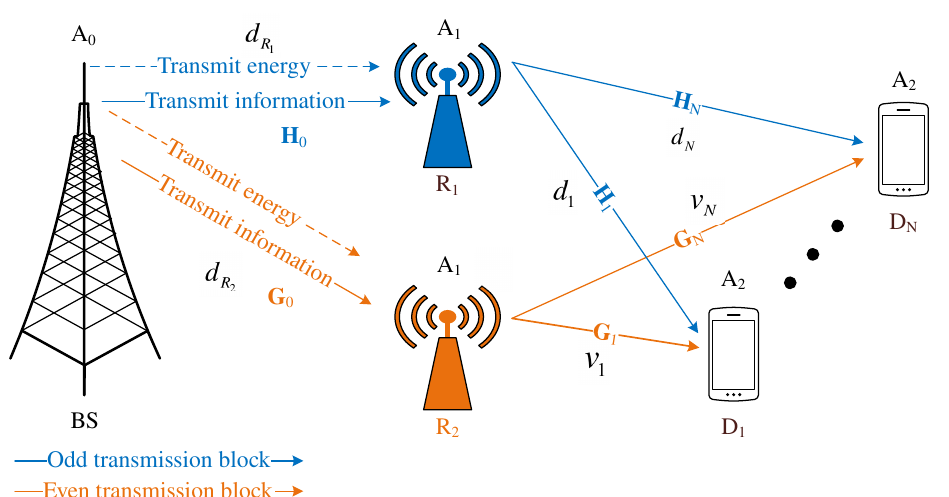
Figure 1. Coupled relays in a cooperative MIMO-NOMA network with the application of TAS and